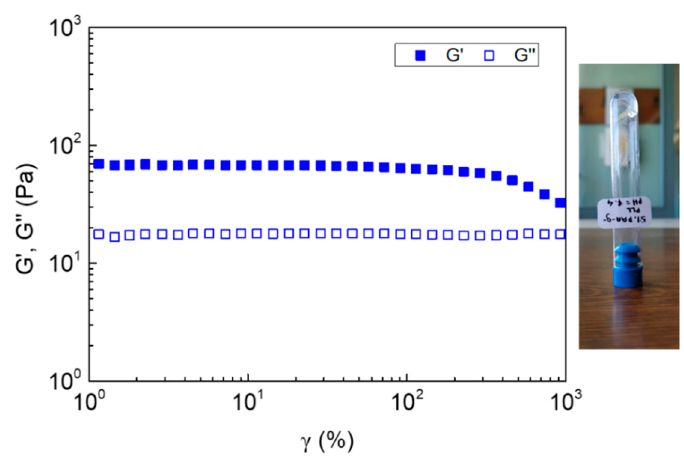
Figure 10. G’ and G” as a function of strain at 1 Hz of the PAA-g-PLL aqueous formulation (C P = 5 wt %, pH 7.4). The digital photo depicts the free-standing hydrogel.